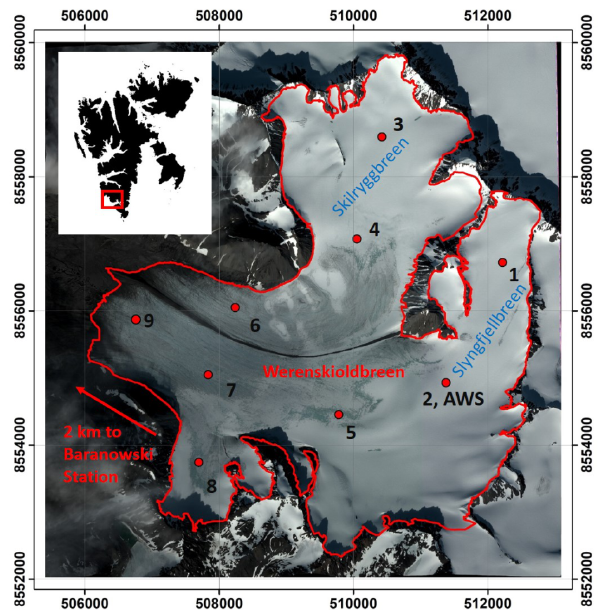
Figure 1. Location of mass-balance stakes (1–9) for 2009–2020 and the automatic weather station (AWS) on Werenskioldbreen (background: GeoEye, 10 August